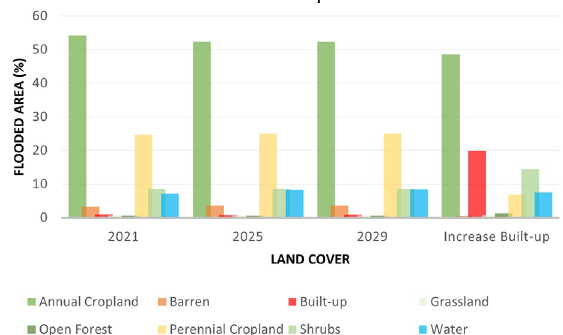
Figure 14. Flooded areas for each land cover with a 5-year rainfall return period.